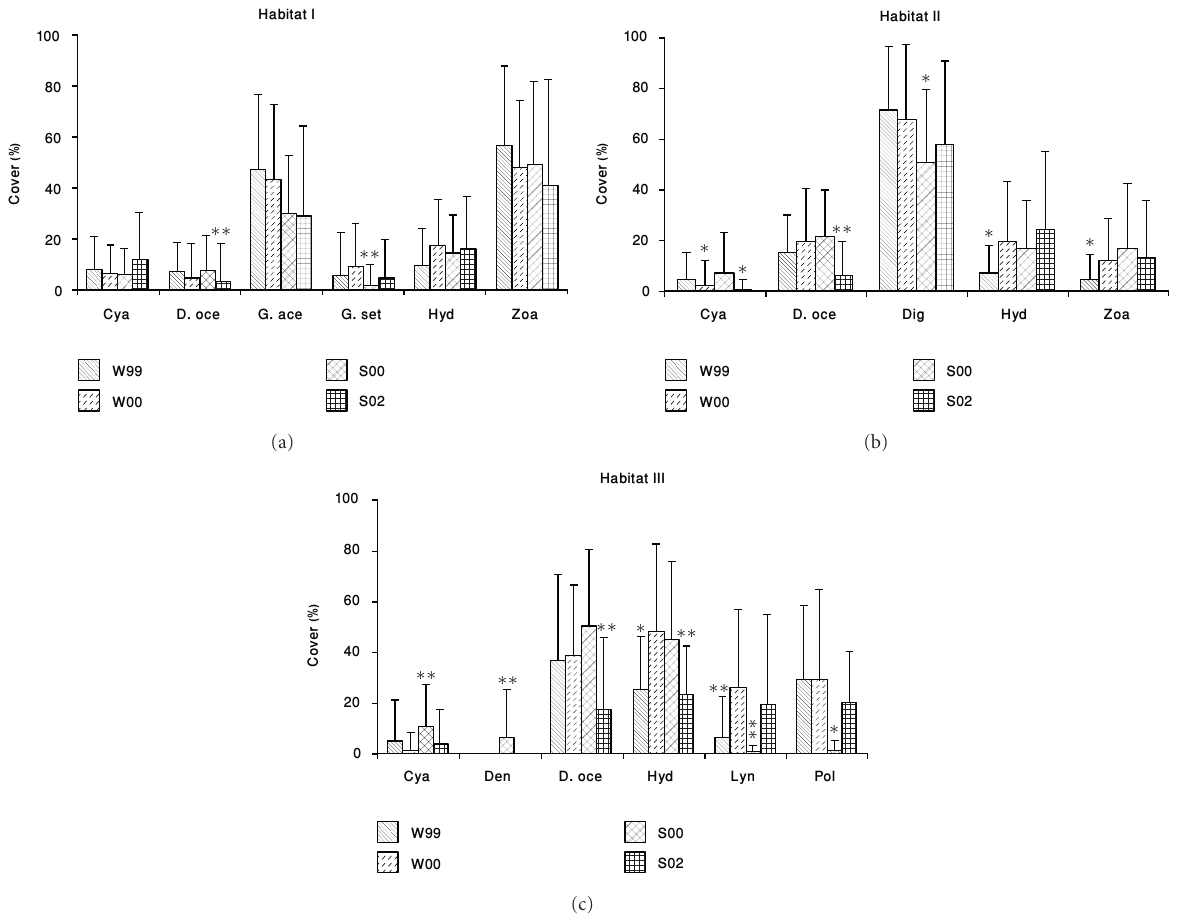
Figure 4: Mean percentage cover and SD for the more representative benthic organisms in the three habitats of the reef flat, pointing the significant post hoc multiple comparisons tests results ( ∗ p < 0 . 05; ∗∗ p < 0 . 01); Cya: Cyanobacteria, Den: Dendropoma sp., Dig: Digenea simplex , D.oce: Dictyosphaeria ocellata , G.ace: Gelidiella acerosa , G.set: Gelidiella setacea , Hyd: Hydrolithon pachydermum , Lyn: Lyngbya confervoides , Pol: Polychaeta tube, Zoa: Zoanthus sociatus ; W99: winter 1999, W00: winter 2000, S00: summer 2000, S02: summer